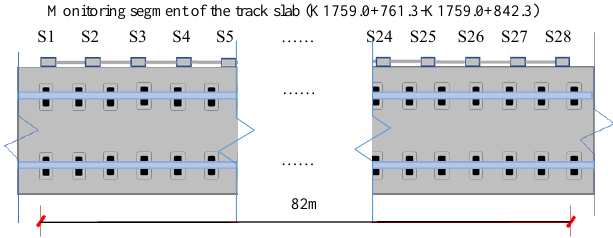
Figure 10. Sensor layout for the monitoring track slabs.